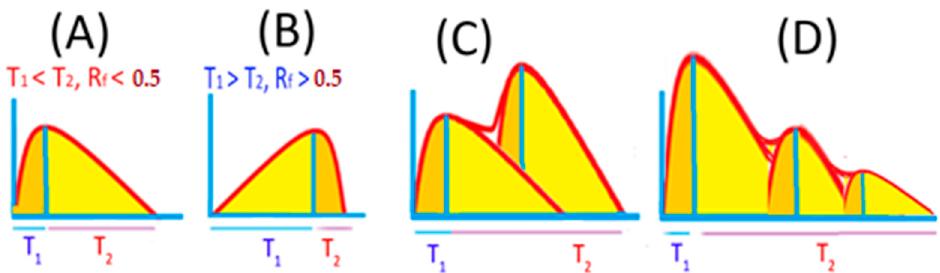
Figure 1. Schematic diagrams exhibit the time profiles of the two types of flares, sudden and gradual flares. As well as these have multiple and complex peaks. The X-axis represents the time. It splits into two intervals, T1 and T2, which are corresponding to the rising and falling intervals respectively. The Y-axis is the flare's X-ray flux or count rate. ( A ) denotes the case of the sudden flare. While ( B ) denotes the case of the gradual flare. ( C , D ) refer to the flares of multiple peaks. However, ( C ) is considered a gradual flare. Whereas ( D ) is considered a sudden flare.